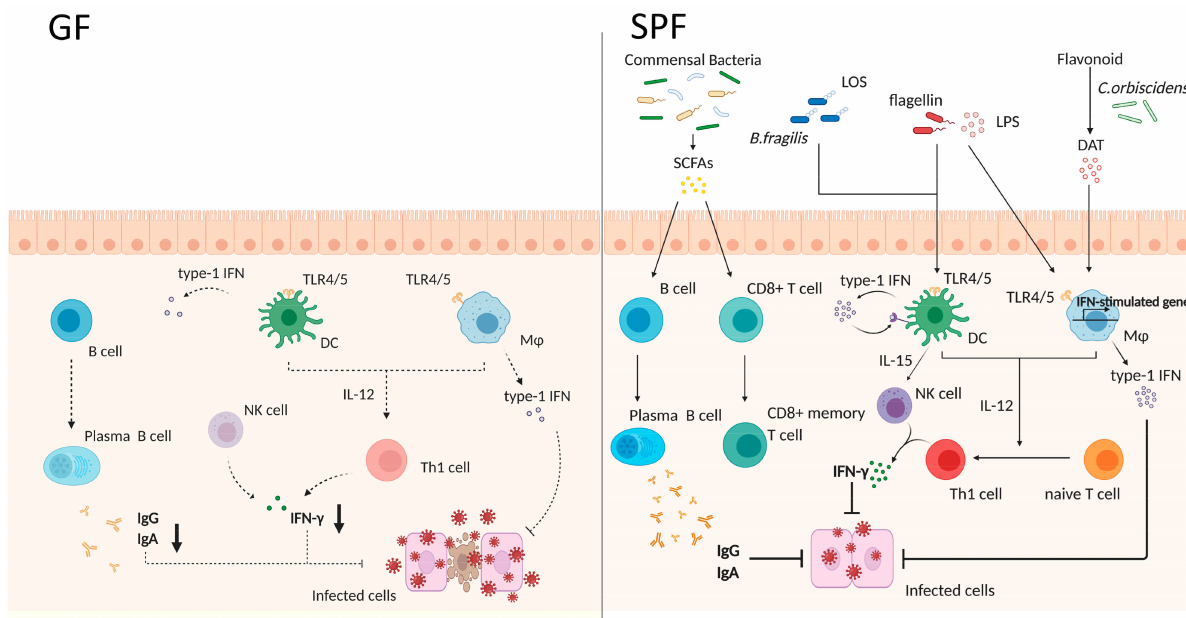
Figure 2. The gut microbiota is required for optimal innate immunity-mediated immune responses. The left panel shows the intestinal environment of germ-free (GF) mice. Because GF mice have no commensal bacteria, intestinal innate immune cells are less stimulated, and, consequently, secrete lower levels of cytokines. Moreover, B cells fail to differentiate into plasma cells, resulting in lower antibody secretion (IgG and IgA). The lower activity of immune cells renders the animals more susceptible to viral infection. On the other hand, in the right panel, specific-pathogen-free (SPF) mice harbor a lot of commensals, which affect host immune cells through microbe-derived components and metabolites. Microbe-associated molecular patterns (MAMPs) such as lipopolysaccharide (LPS), flagellin, and lipooligosaccharide (LOS) are recognized by pattern recognition receptors (PRRs), expressed by macrophages (Mø) and dendritic cells (DCs). These antigen-presenting cells produce type 1 IFN, and subsequently stimulate natural killer (NK) cells. NK cells induce the differentiation of naïve T cells into Th1 cells, which secrete IFN- γ and control virus infection. The microbial metabolite desaminotyrosine (DAT) produced by Clostridium orbiscindens also enhances type 1 IFN production. Additionally, short-chain fatty acids (SCFAs) produced by microbes promote the differentiation of B cells and activated-CD8 + T cells into plasma cells and memory T cells, respectively. Last but not least, plasma cells secrete IgG and IgA, rendering the animals resistant to viral